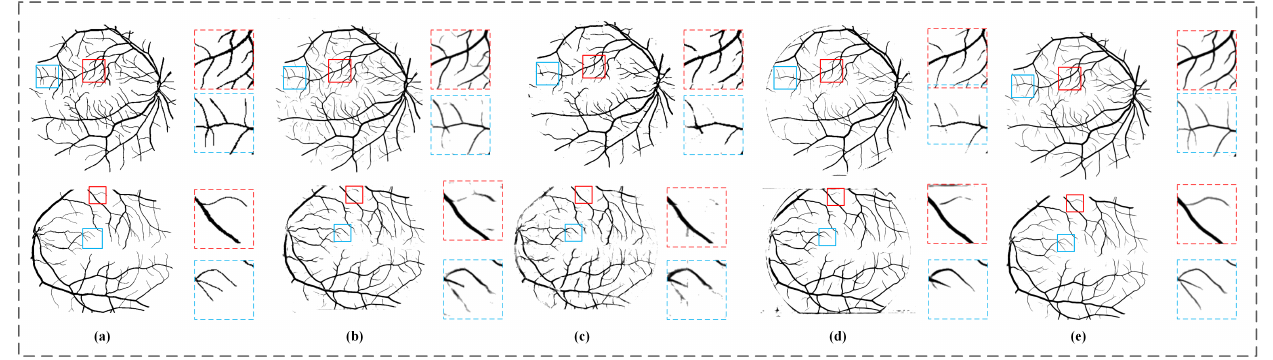
Figure 10. Comparison of segmentation results between our approach and some other advanced approaches. ( a ) The ground truth, ( b ) the segmentation result of UNet model, ( c ) the segmentation result of R2Unet model, ( d ) the segmentation result of CE-Net model and ( e ) the segmentation result of our model. Table 7. Comparison with the most advanced methods on DRIVE and STARE.